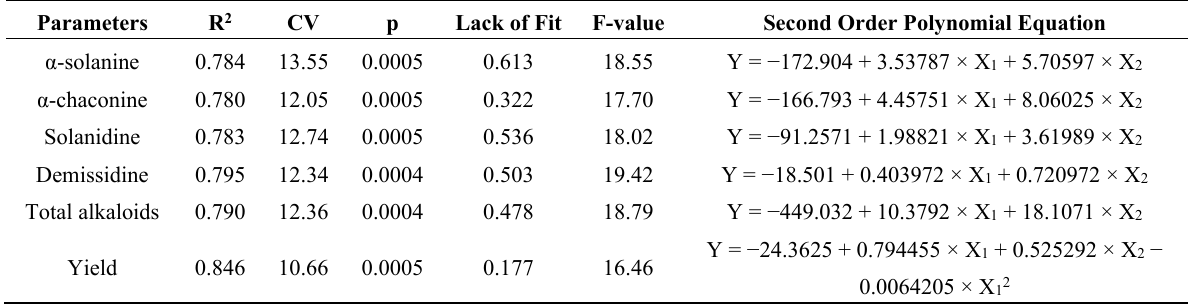
Table 2. Analysis of the variance of the models and predictive second order polynomial equations for different glycoalkaloids in PLE of potato peel.